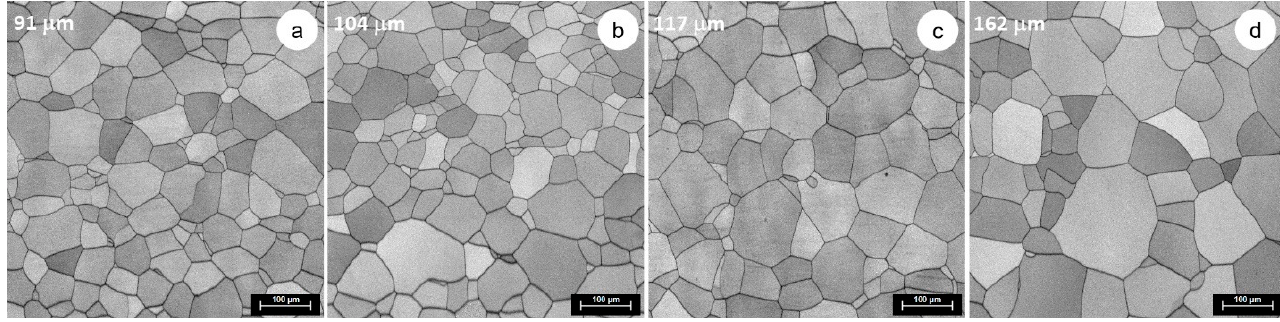
Figure 10. The evolution of grain-size distribution in a TNTZ alloy during ST treatment, as a func- tion of: holding time ( a ) and treatment temperature ( b ).